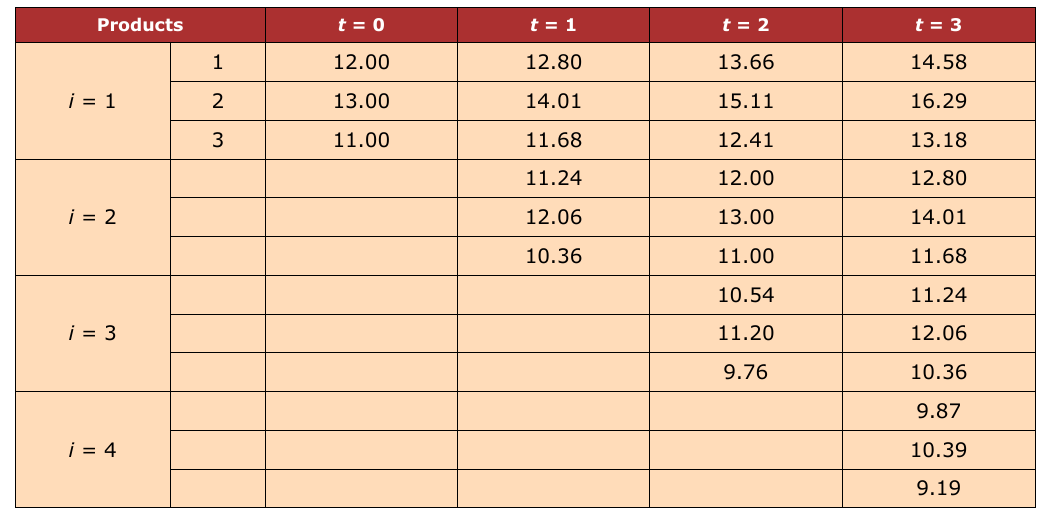
Table 3. The Expected Demand for Products